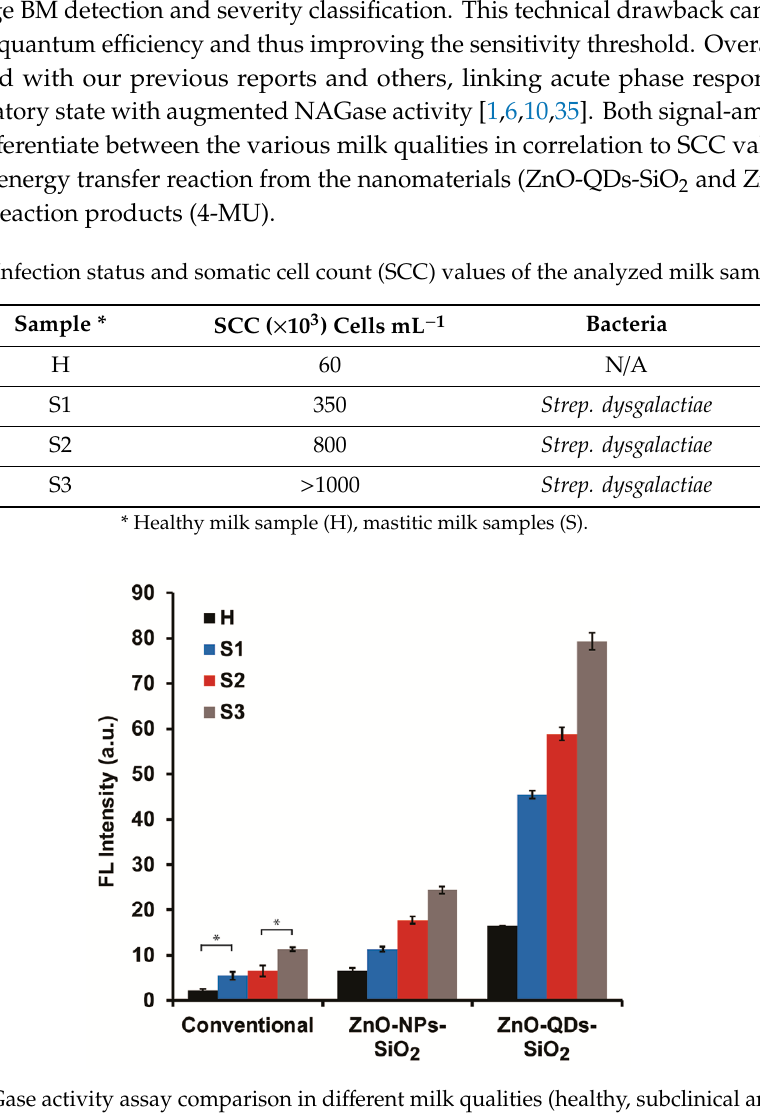
Figure 3. NAGase activity assay comparison in different milk qualities (healthy, subclinical and clinical BM) with and without silica-coated ZnO nanomaterials’ addition to the reaction solution. Data are reported as mean ± S.D. (n ≥ 3). * Significantly different ( t- test, p < 0.05).